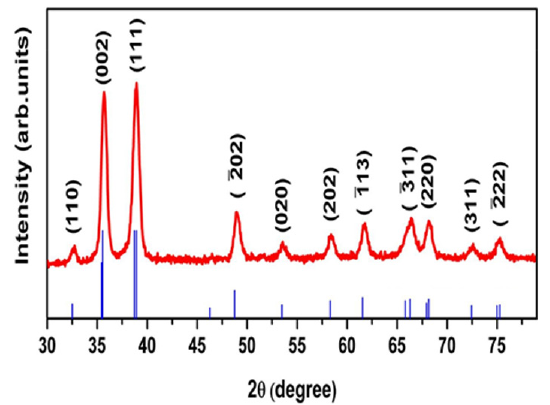
Figure 7: XRD pattern of synthesized CuO NPs at obtained optimum